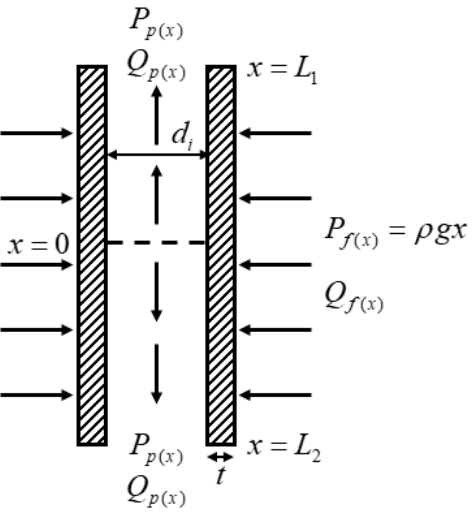
Figure 11. Theoretical model of hollow fibre within submerged membrane systems arranged in double-end suction configuration.